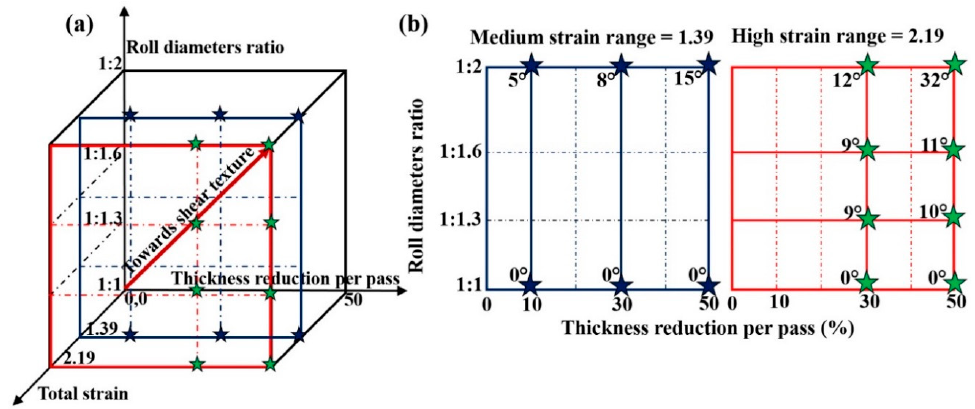
Figure 2. Schematic of the parameter space ( a ) and two sections ( b ) showing the parameter values employed in the present study. The numbers in ( b ) indicate the rotation angle of the rolling texture towards a shear texture, which is identified by the rotation of the f2 rolling component.